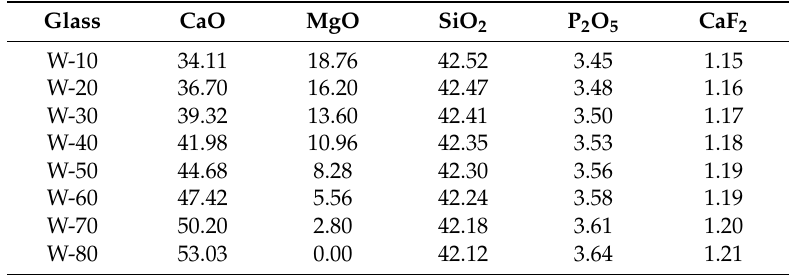
Table 10. Batch compositions of the glasses within Di–FA–wollastonite (W) ternary system (mol %).